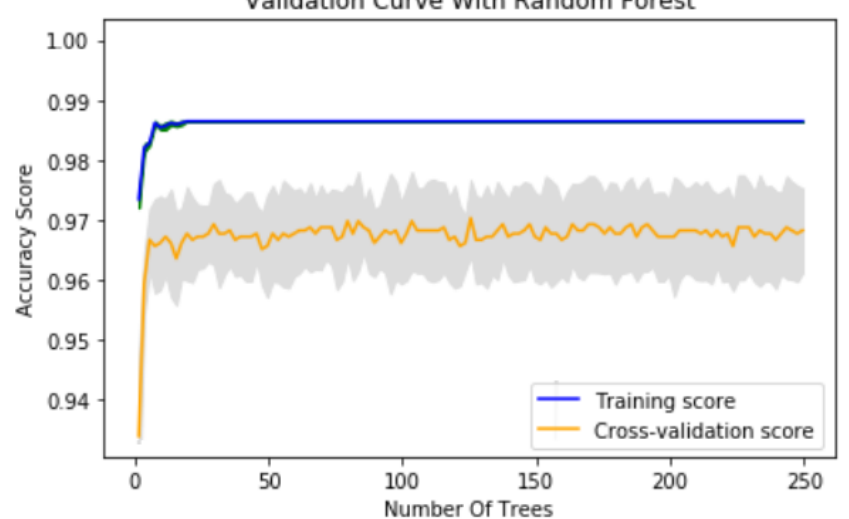
Figure 7. Random Forest Classifier scores for electrofacies